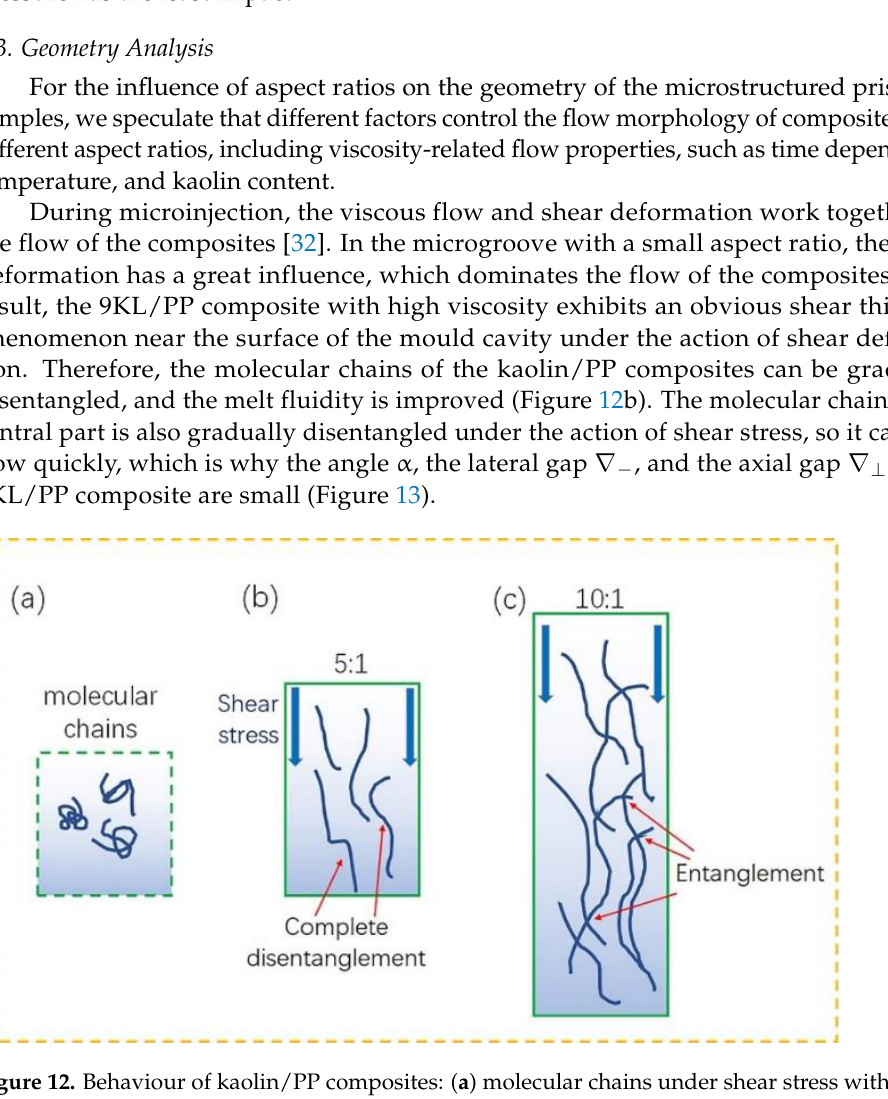
Figure 12. Behaviour of kaolin/PP composites: ( a ) molecular chains under shear stress with aspect ratios of ( b ) 5:1 and ( c ) 10:1.